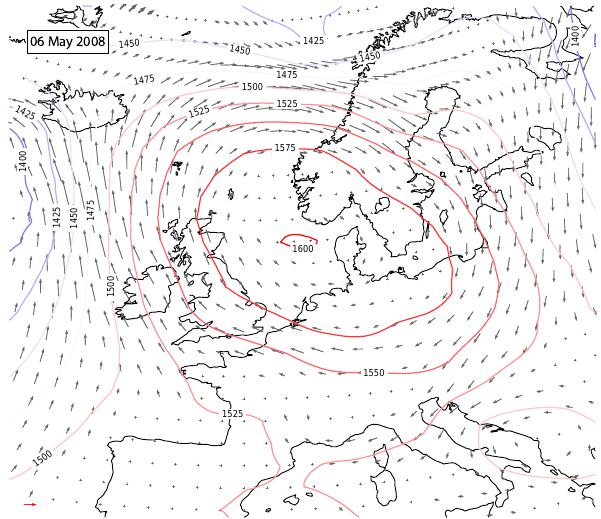
Fig. 2. Map showing the ECMWF re-analysis 850hPa geopoten- tial height (m) at 12:00UTC for the 6 May 2008 flights (B362 and B363). Contour interval is 25 m. Arrows indicate 850hPa wind speed and direction; red arrow in lower left corner illustrates a west- erly 10ms − 1